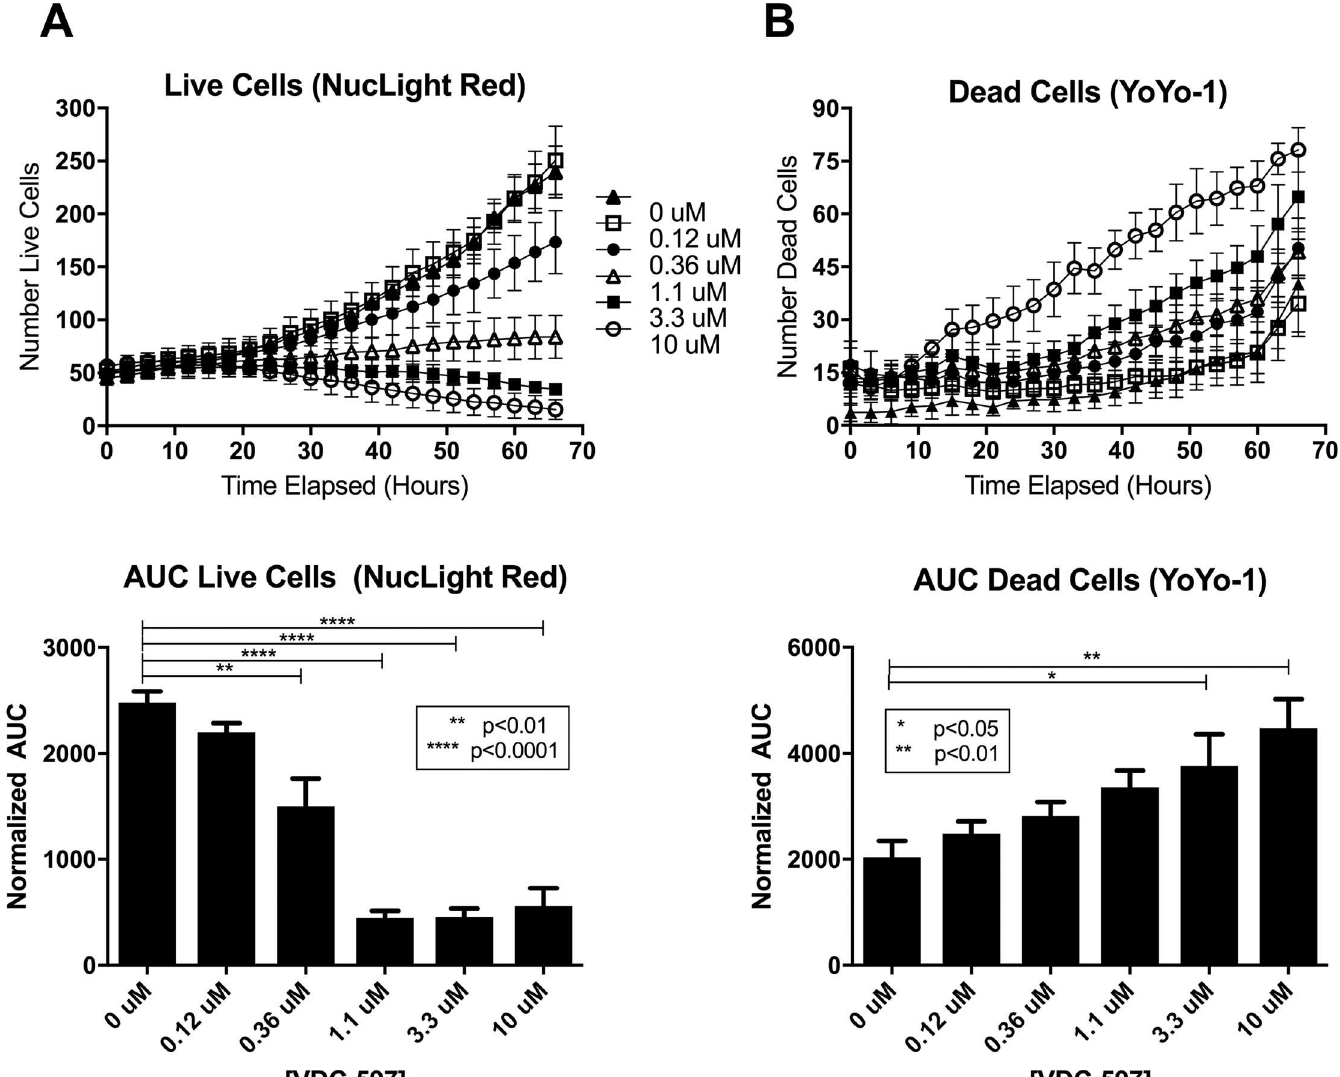
Fig 5. VDC-597 inhibits proliferation and induces apoptosis of canine hemangiosarcoma cells. NucLight Red-expressing SB-HSA cells were incubated for 72 hours with C/10 or C/10 with various concentrations of VDC-597 with the addition of YoYo-1 iodide reagent to label apoptotic cells. The number of viable ( A ) and number of apoptotic ( B ) cells per well were determined using an IncuCyte real-time videomicroscopy system. Area under the curve for each condition was calculated. Asterisks indicate P values less than 0.05. Error bars indicate standard error measurements.